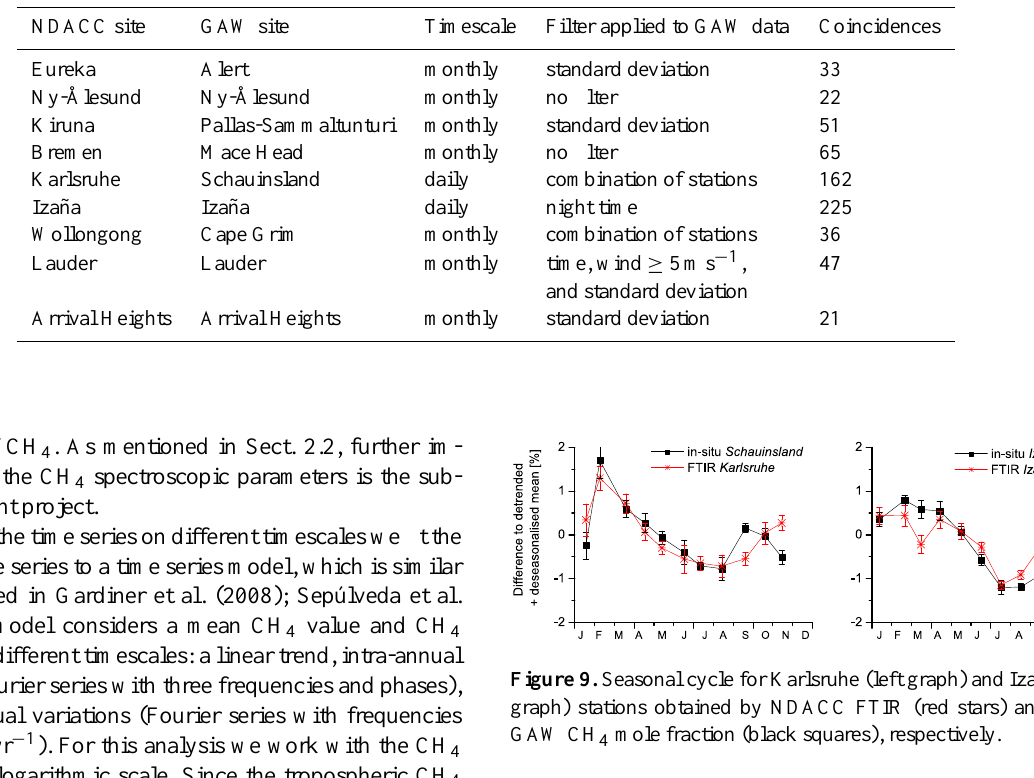
Table 5. NDACC FTIR vs. GAW tropospheric CH 4 data comparison: stations, timescales, filter applied for obtaining regional-scale GAW data, and number of coincidences.